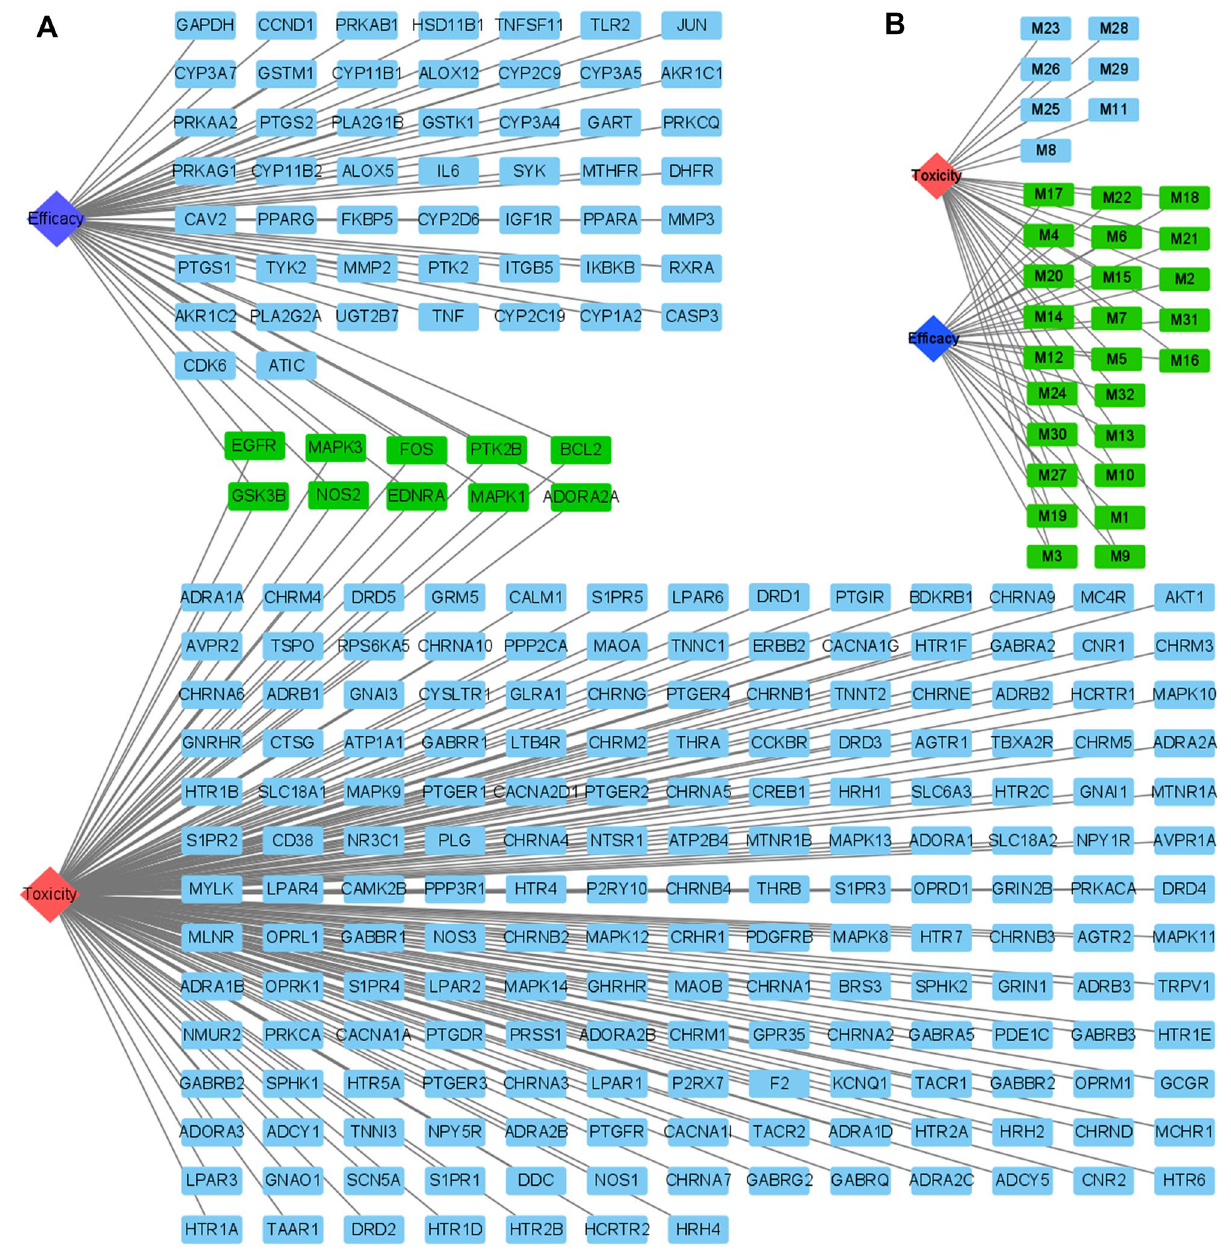
Figure 9. Comparison of the compounds and targets that are responsible for the toxicity and efficacy of Fuzi. The full name of compounds and targets are shown in Table 1 and Supplementary Table S1,